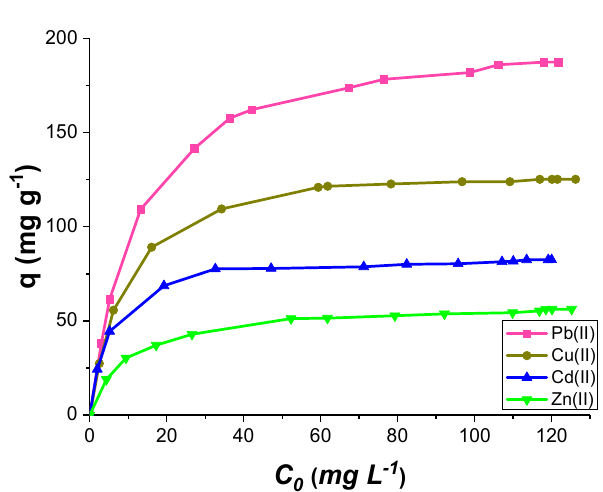
Figure 8. Effect of concentration on metal ions adsorption onto SiTF 5 PP (Adsorption dose: 10 mg; V = 10 mL; T = 25 °C; and pH = 6). Lines just combine the points.